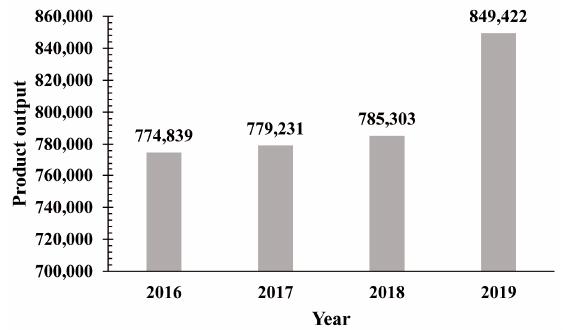
Figure 7. Enterprise Q’s total output from 2016 to 2019 (standardized product count).